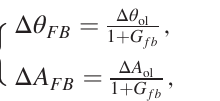
FIG. 8. Comparison of calibrated amplitude (and phase) drift and measured amplitude (and phase) on cavity ML2 that operated at 10.5 MV. From top to bottom: Δ f Δ f ¼ − 8 Hz. offset